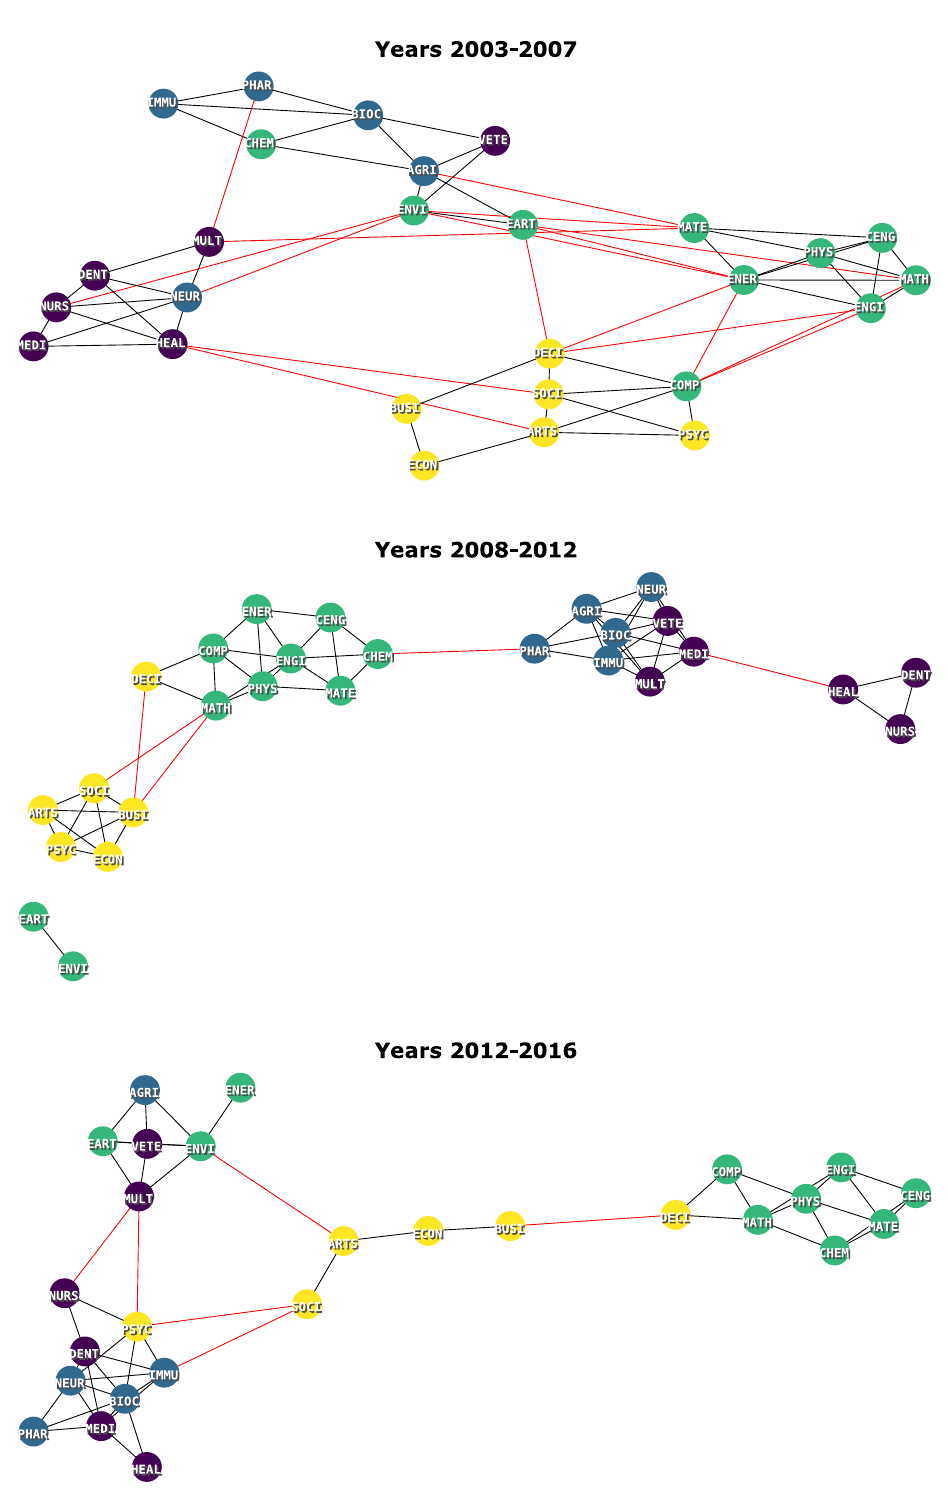
Fig 11. Backbone network. Backbone with α = 0.20 of the space created by the embedding model for the intermediate areas, for different time intervals. The color of the edge represents whether it is inter-group ( red ) or intra-group ( black ). The color of the vertex represents the associated macro